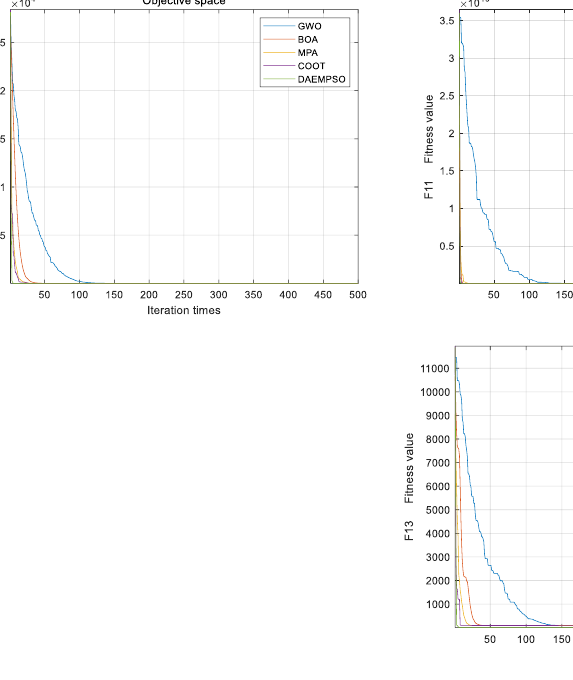
Figure 8. Bonferroni –Dunn’s test for different methods and groups with α = 0.1.